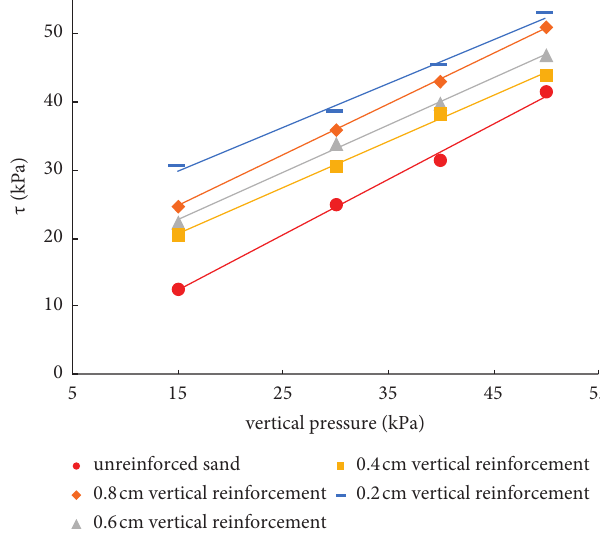
Figure 16: Shear strength curves of vertical-reinforced kraft paper with different